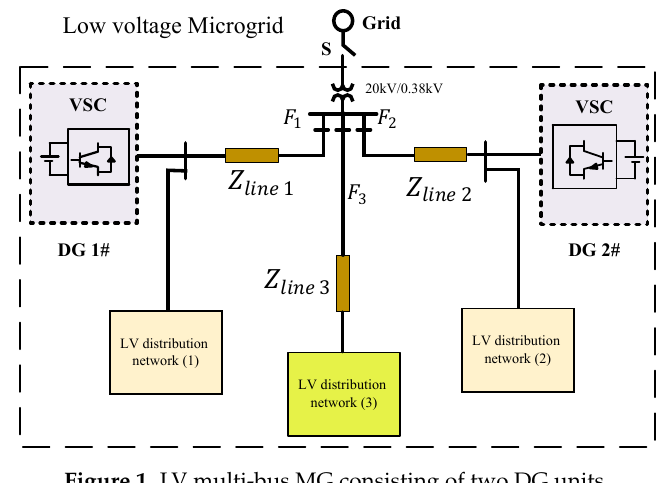
Figure 1. LV multi-bus MG consisting of two DG